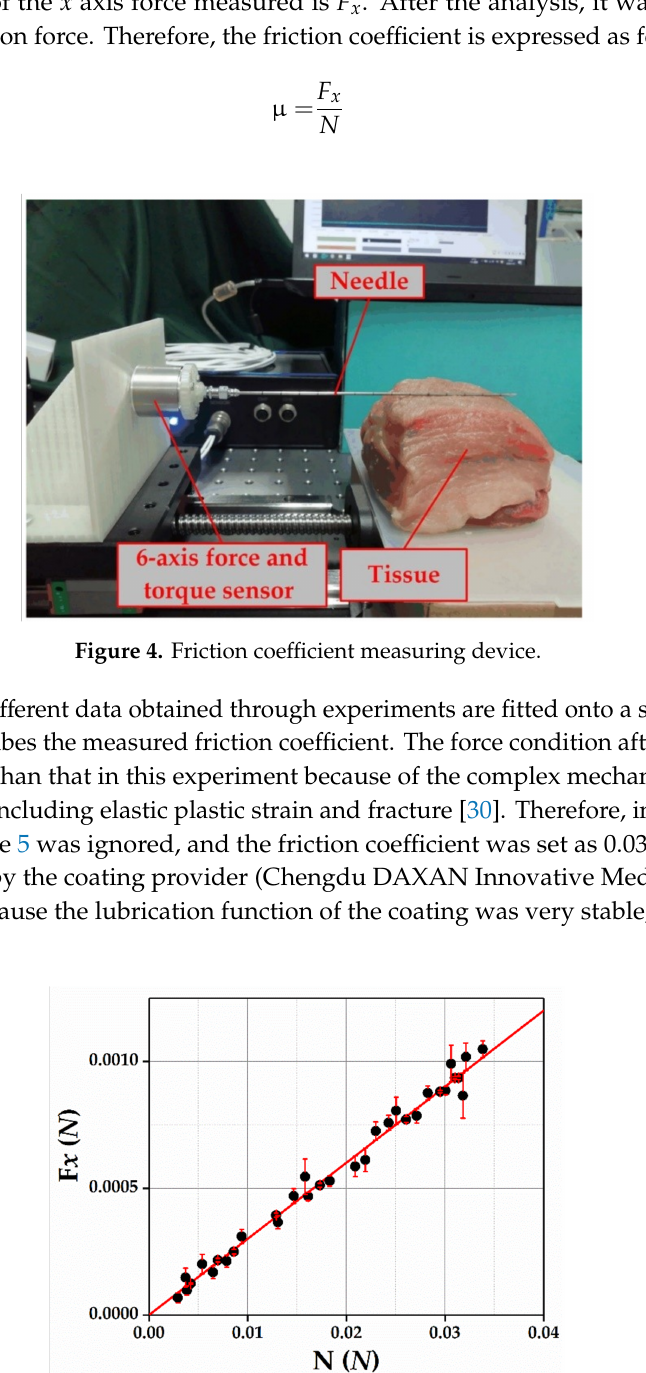
Figure 5. Experimental data for the measurement of the friction coe ffi